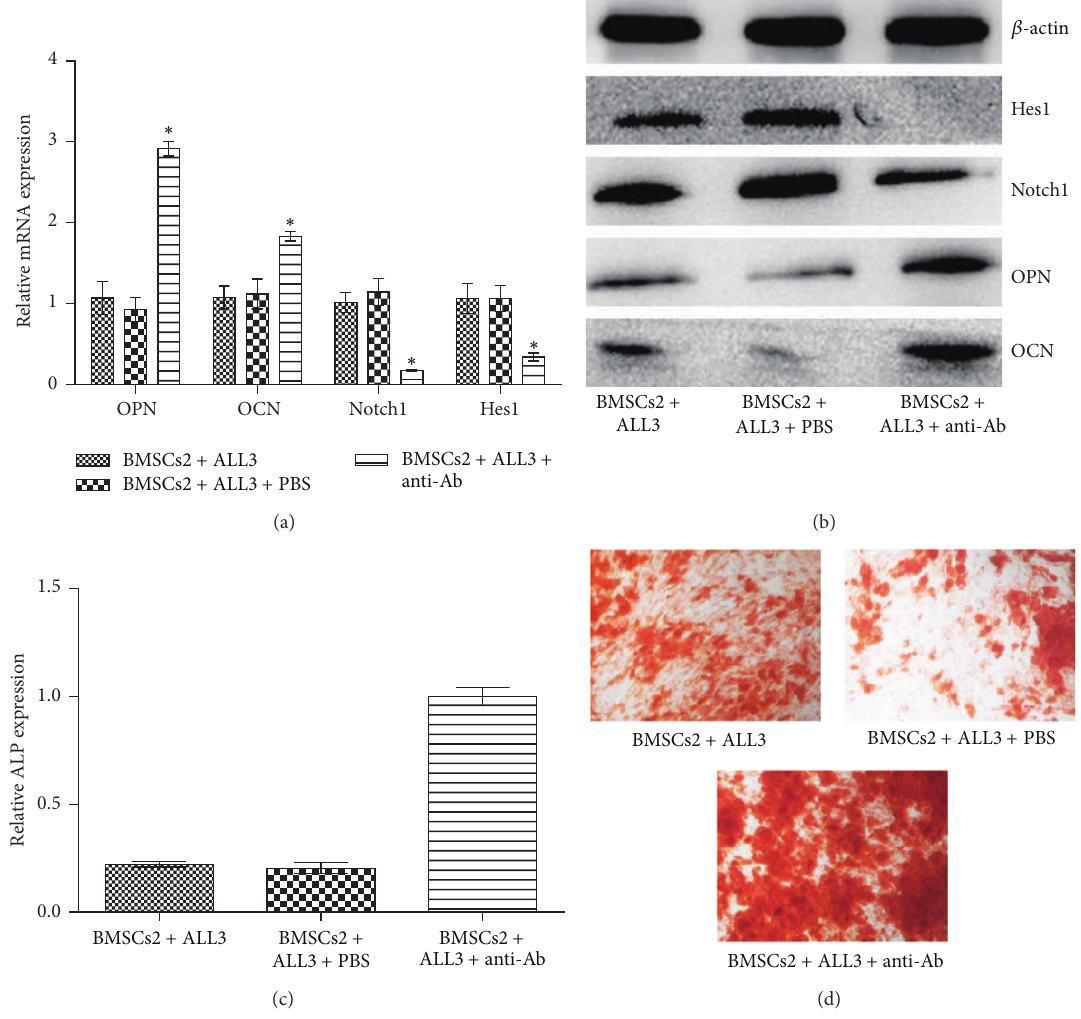
Figure 4: Effect of anti-Jagged1 neutralizing Ab on osteoblast differentiation of BMSCs in cocultures. BMSCs2 and ALL cells were cocultured with or without anti-Jagged1 neutralizing Ab under osteogenic conditions for 3 days or 14 days. (a-b) The mRNA and protein expression levels of osteogenic differentiation markers OPN and OCN, and Notch1 and Hes1 were analyzed using real-time RT-PCR and western blot analysis after 3-day coculture. (c) ALP levels were detected using an ALP kit ( ∗ 𝑃 < 0.05 versus BMSCs2 cocultured with ALL cells). (d) Calcium deposits were detected using von Kossa